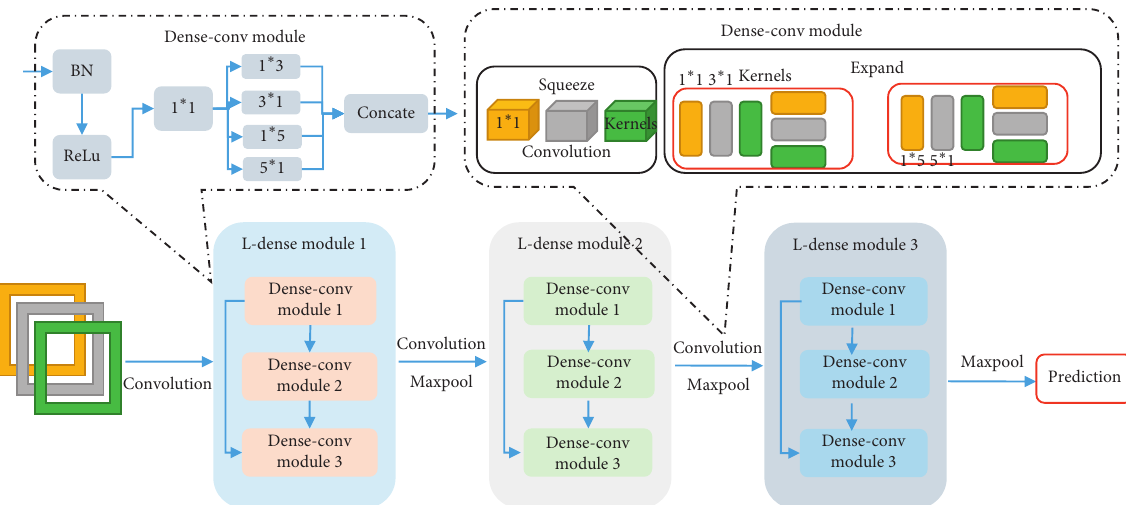
Figure 3: The overall framework of the L-DenseNet